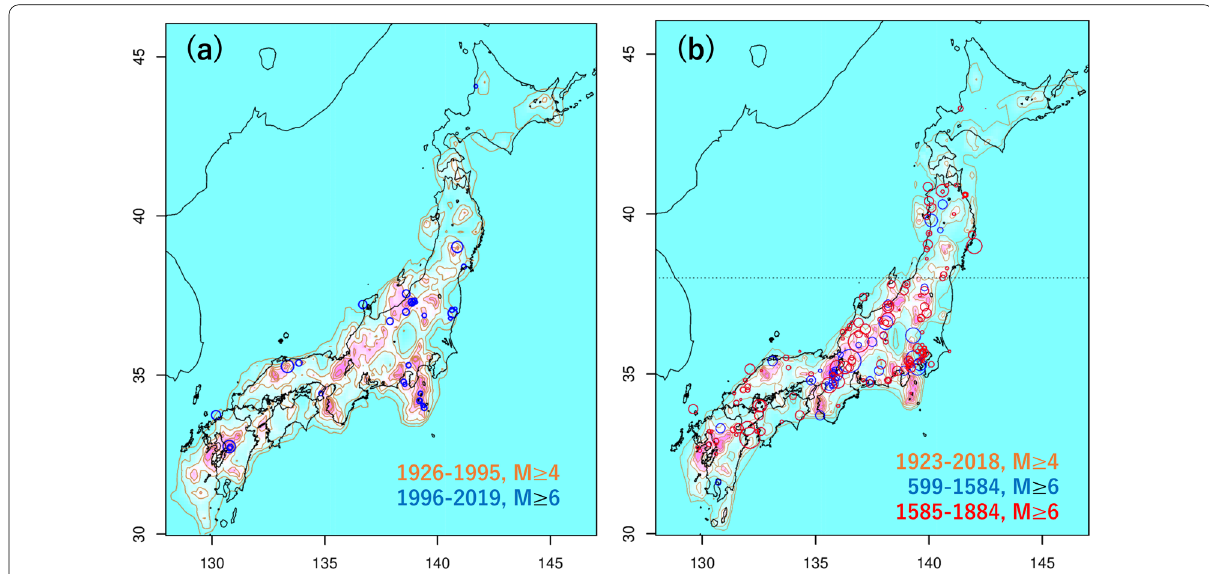
Fig. 4 a Blue circles represent shallow earthquakes of M 6 that occurred during the period 1996–2019 and the color image with contours ≥ represents the μ value distribution of the HIST–ETAS–5pa model for the period 1926–1995. b Blue and red circles show the locations of historical damaging earthquakes before and after 1585, respectively. The horizontal dotted line indicates 38°N. The color image with contours represents the μ value distribution of the HIST–ETAS–5pa model for the period 1926–2018. The color scale for both ( a ) and ( b ) are the same as in Fig. 3 and